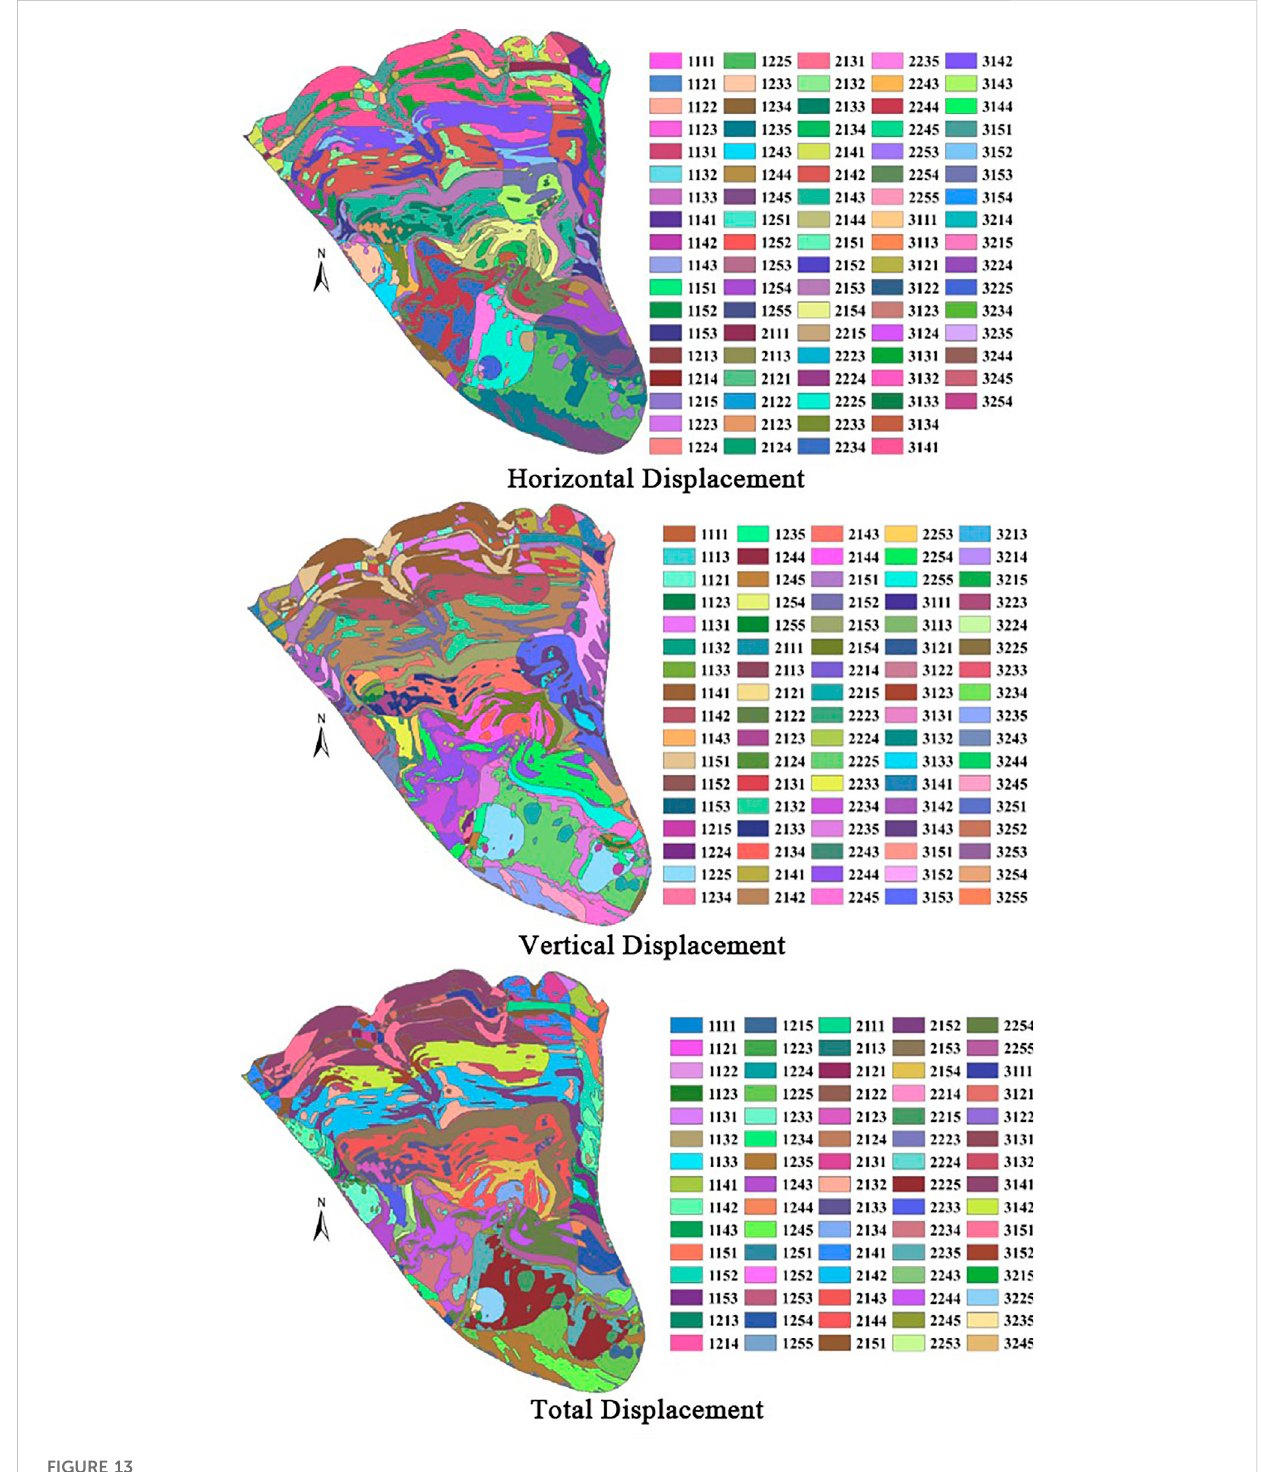
FIGURE 13 Superposition of displacement geometric